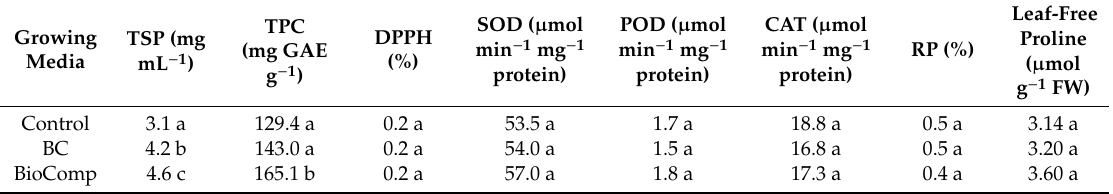
Table 7. Impact of di ff erent growing media on biochemical characteristics of Syngonium podophyllum. Growing